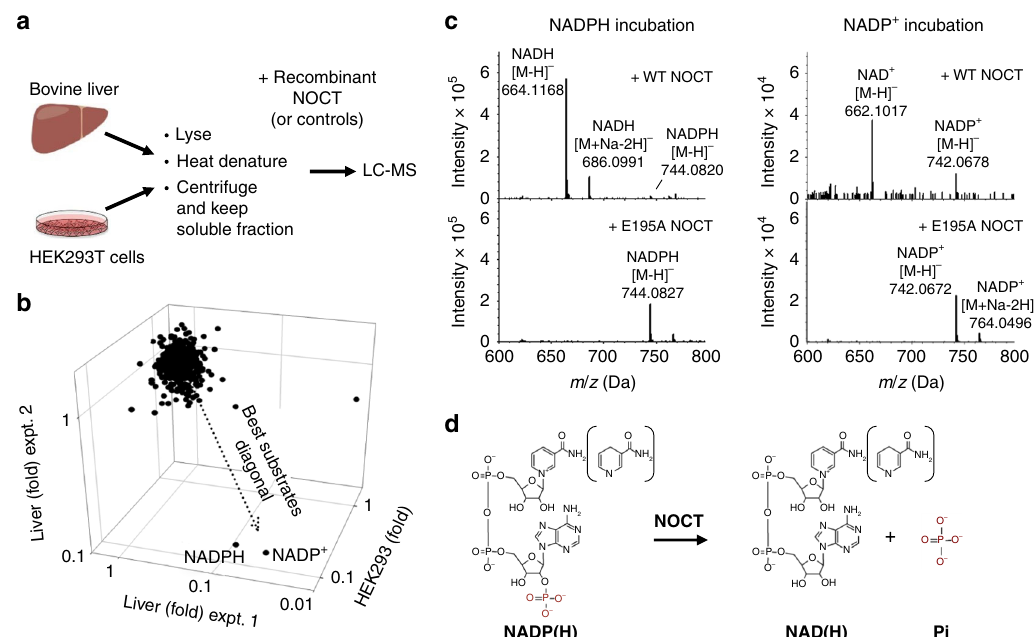
Fig. 1 Metabolite pro fi ling to identify NOCT substrate. a Metabolite extraction and treatment outline. Full-length human NOCT and the catalytic domain of NOCT (residues 122 – 431) were compared against full-length human NOCT E195A, NOCT (122 – 431) E195A mutant, or the catalytic domain of CNOT6L (158 – 555). Liver experiment 1 and HEK293 experiment used the catalytic domain of NOCT. Liver experiment 2 used GST-tagged full-length NOCT immobilized on glutathione beads. b Metabolite depletion in three independent experiments (Supplementary Data Set 1). Fold is de fi ned as the ratio of LC- MS intensities for samples with WT NOCT vs average for samples with NOCT E195A and CNOT6L. c LC-MS/MS analysis of puri fi ed NADP + and NADPH following incubation with WT or E195A human NOCT (122 – 431; 10 μ M, 1 h at r.t.). d The identi fi ed reactions catalyzed by human